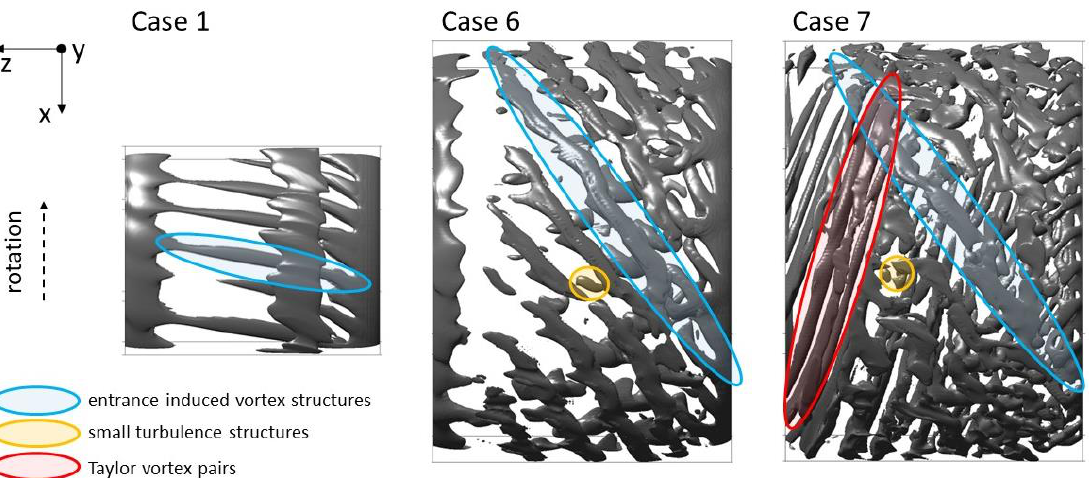
Figure 16. Top view of 𝜆 − 2 iso-surfaces inside the air gap obtained from simulations of the three different flow cases from Lee [6]. different flow cases from Lee